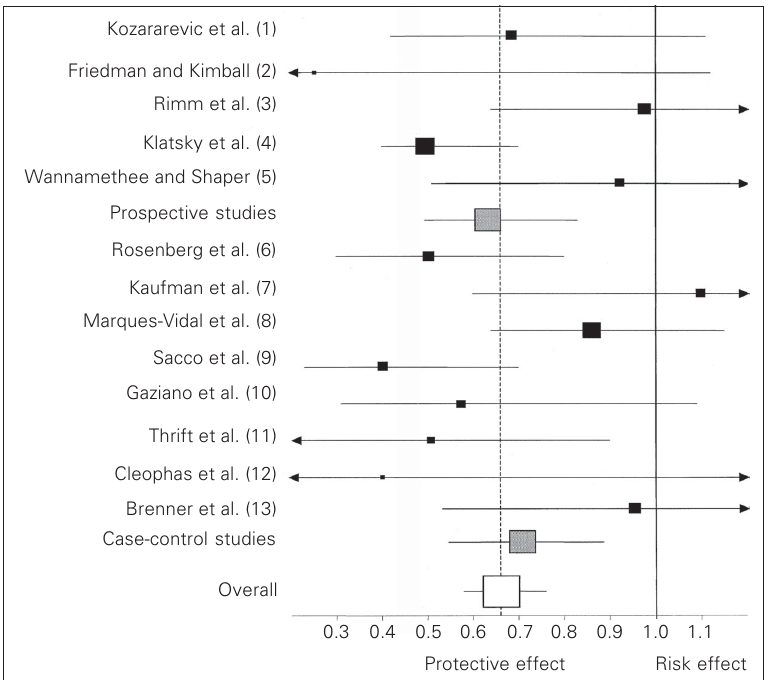
Figure 2. Meta-analysis of wine and beer intake and vascular risk (see text). Modified from Ref. 11, with